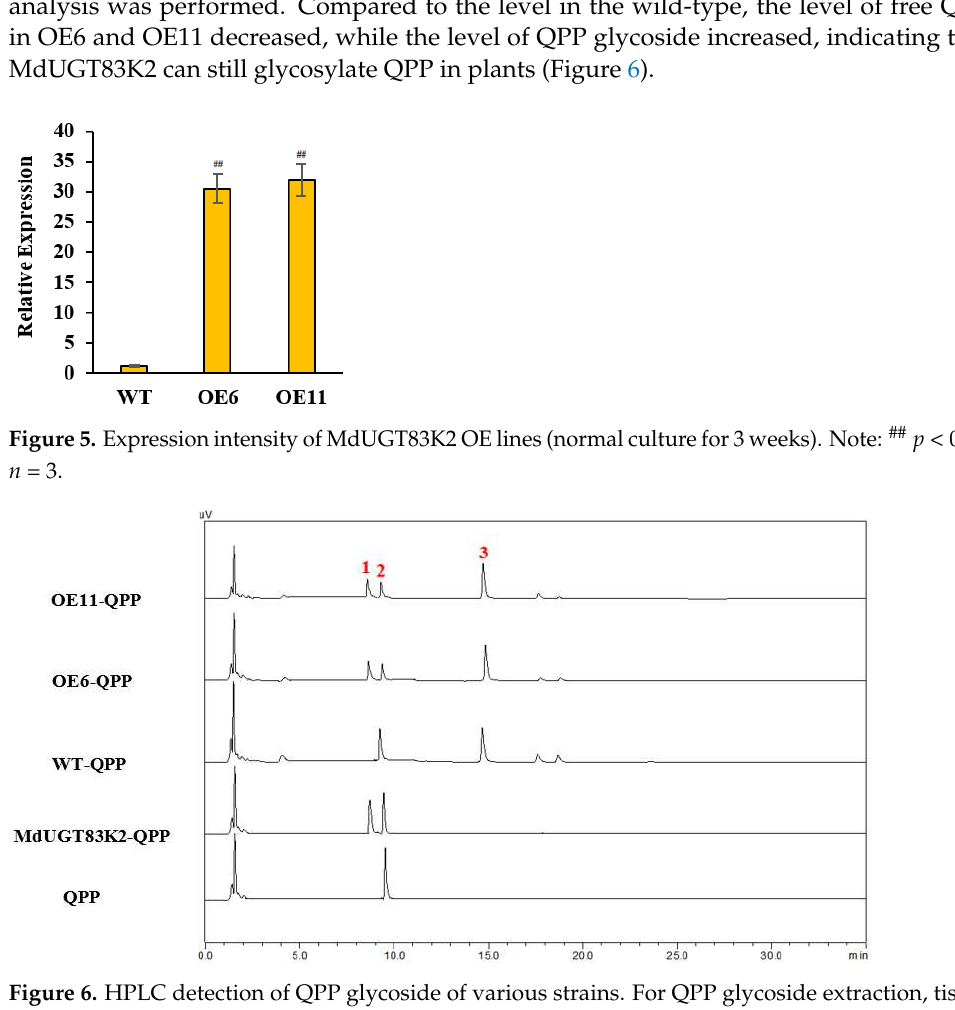
Figure 4. HPLC analysis of reaction products from induced by herbicide QPP by MdUGT83K2. The MdUGT83K2 prokaryotic expression vector was constructed and expressed into E. coli protein strain